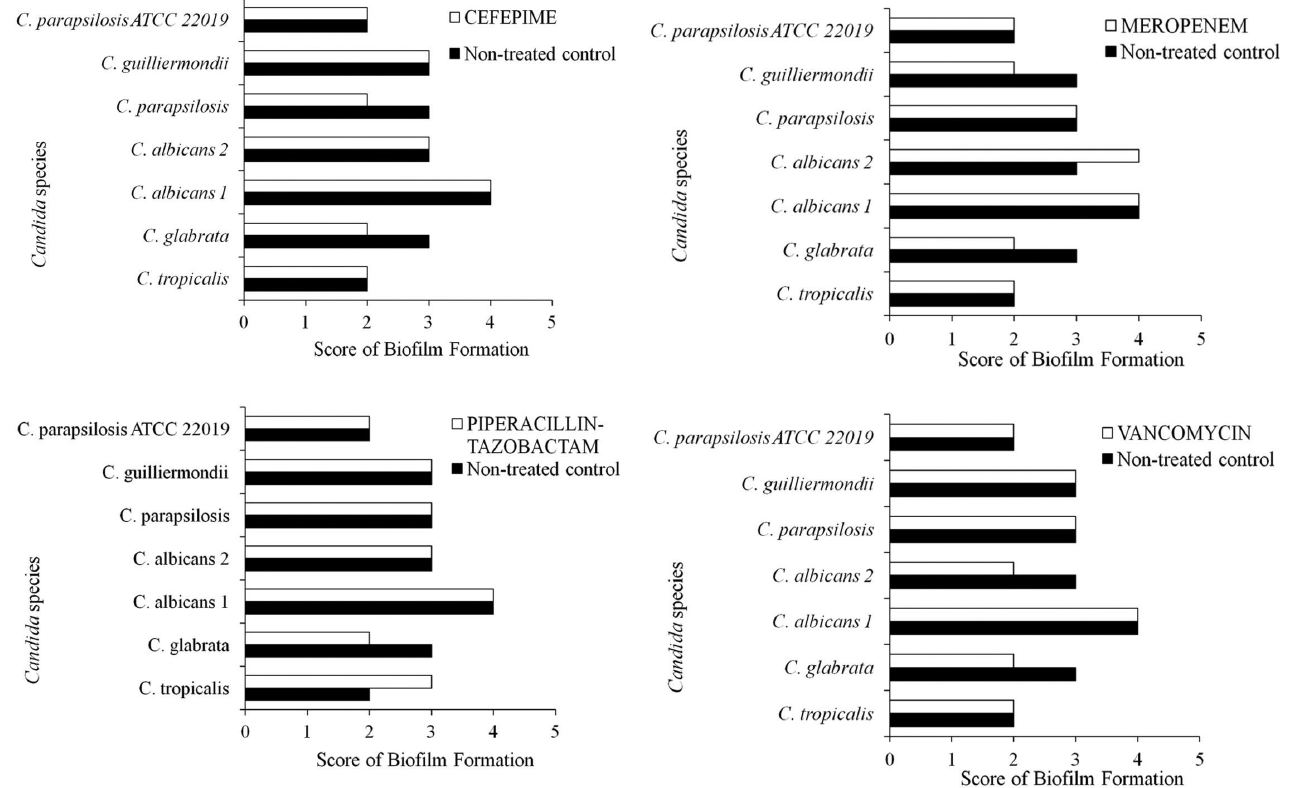
FIGURE 1 – Capacity of Candida species to form biofilm after treatment with